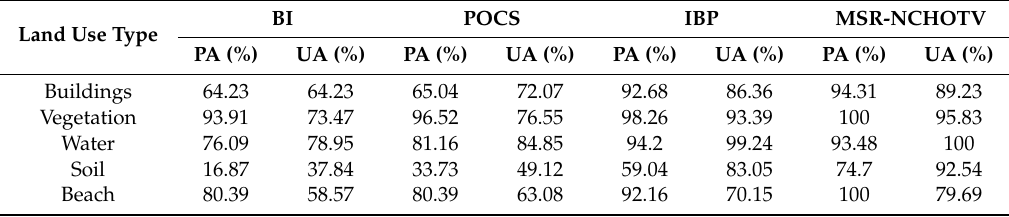
Table 5. Results of the producer’s accuracy (PA) and user’s accuracy (UA) of the four SRR methods. Land Use Type